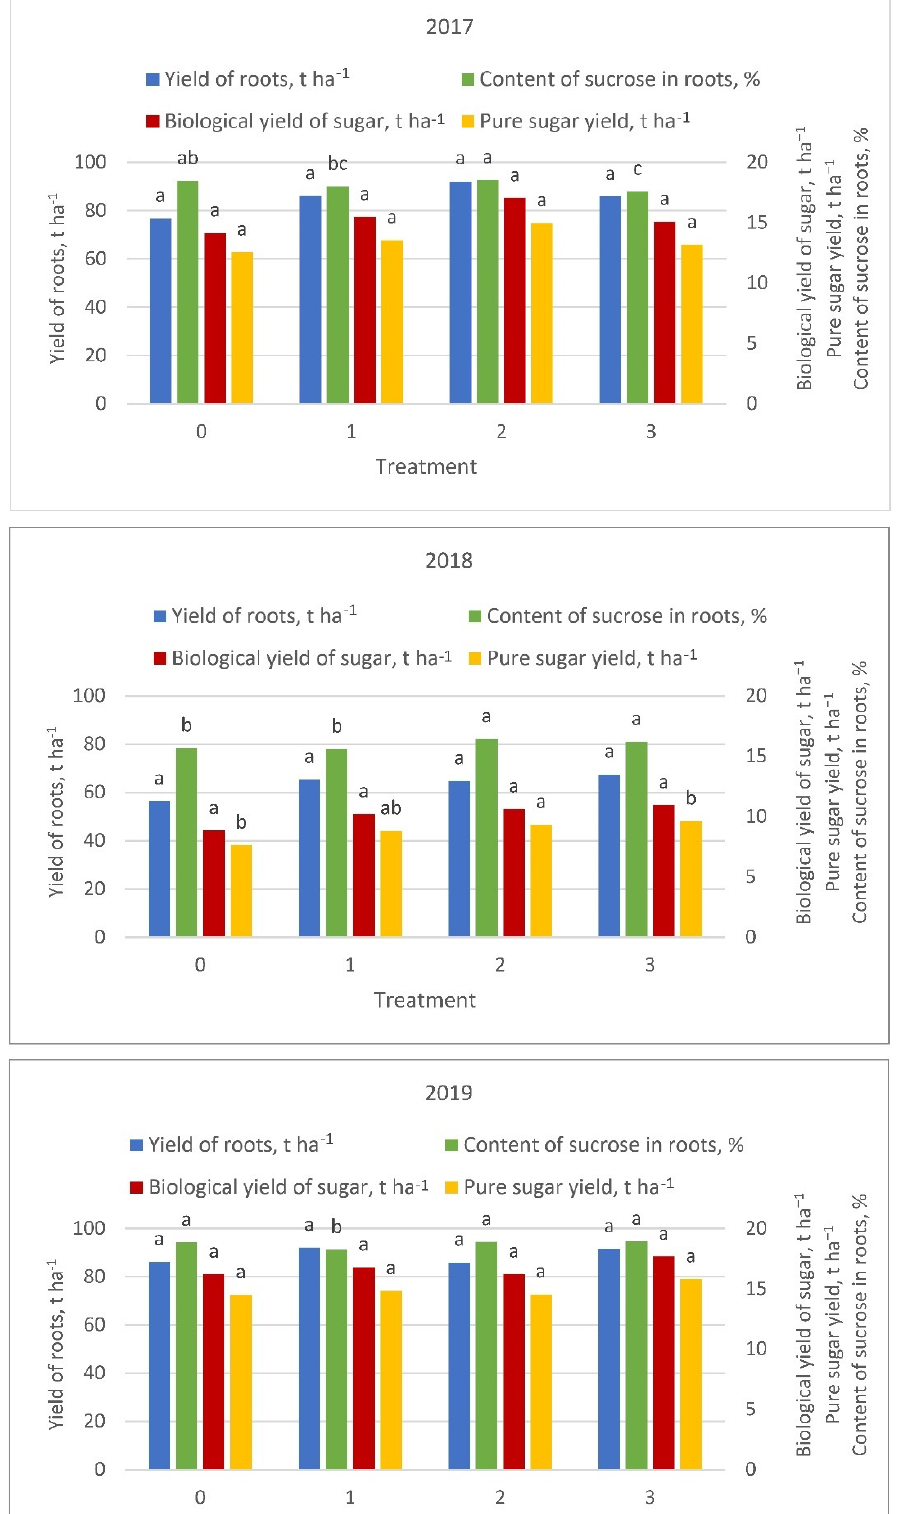
Figure 2. Means for the treatments of foliar fertilization of silicon of yield of roots, sugar yield and sucrose content in years 2017–2019 and their statistical comparisons. (The same letters for the columns in the same colour indicate homogenous groups of the means at α =